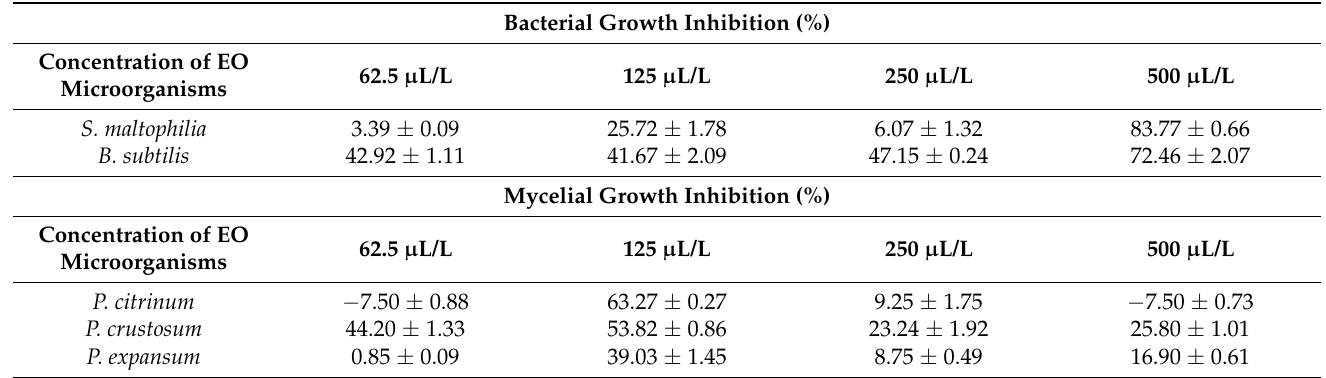
Table 4. Results of in situ analysis of antibacterial activity of the vapor phase of T. serpyllum essential oil on carrots. Bacterial Growth Inhibition